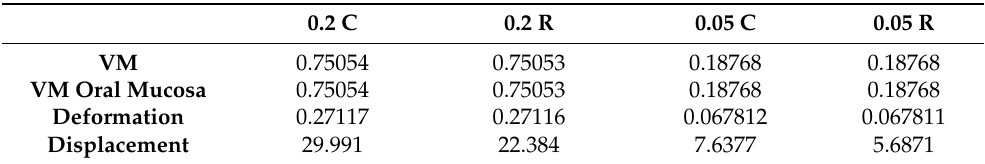
Table 2. Von Mises Stress (VM) on Jaw bone (Mpa), Von Mises Stress on Oral Mucosa (Mpa), Deformation (Micron) and displacement